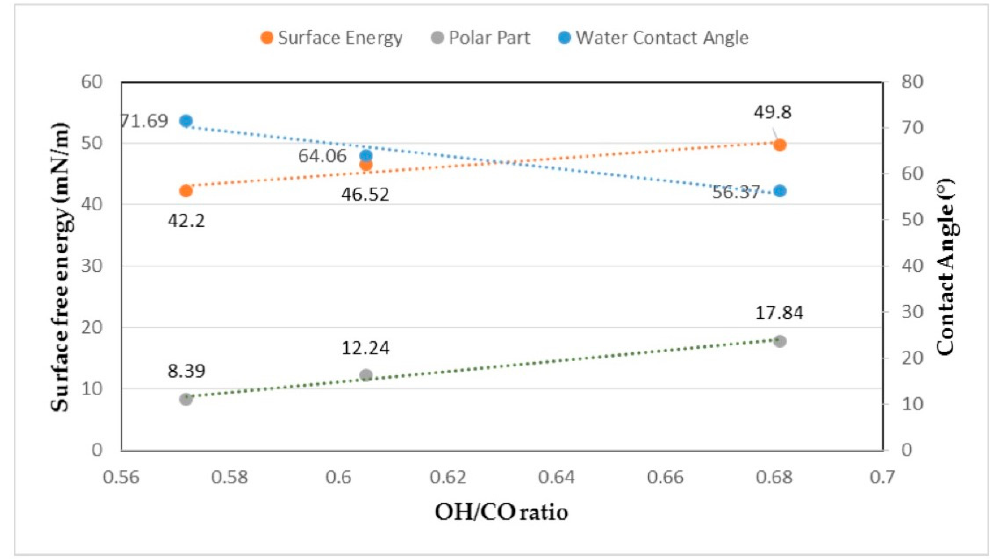
Figure 7. Influence of OH/CO ratio on the contact angle, surface free energy and polar part of the surface free energy of the films (the values of OH/CO for different CNF suspensions are: CNF UG = 0.681, CNF 50G = 0.605, CNF 100G = 0.572).